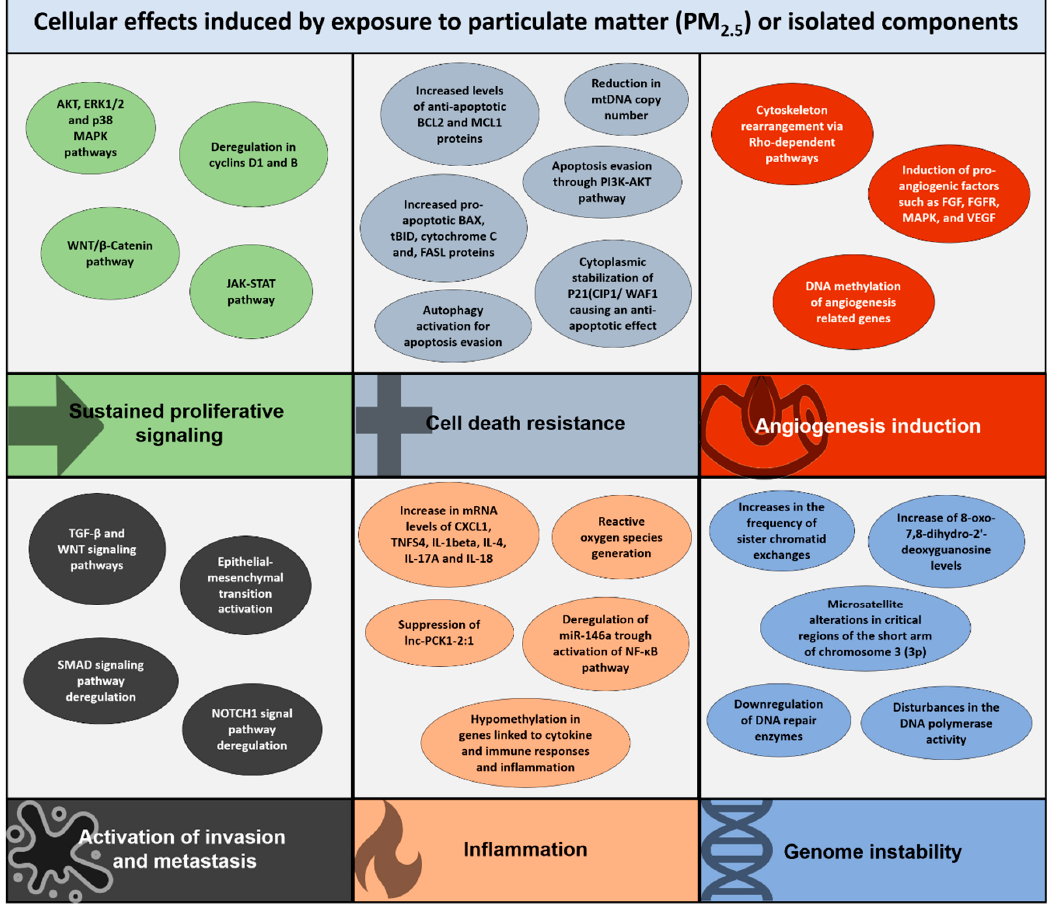
Figure 1. Particulate matter (PM) with an aerodynamic diameter less than 2.5 micrometers (PM 2.5 ) or some of its components, such as polycyclic aromatic hydrocarbons (PAHs), have an impact on cell signaling pathways or cellular deregulations considered as key events during tumor development and known as hallmarks of cancer. However, some of these hallmarks are still negative for PM 2.5 exposure, including induction of mutations, replicative immortality acquisition, and immune cell destruction.